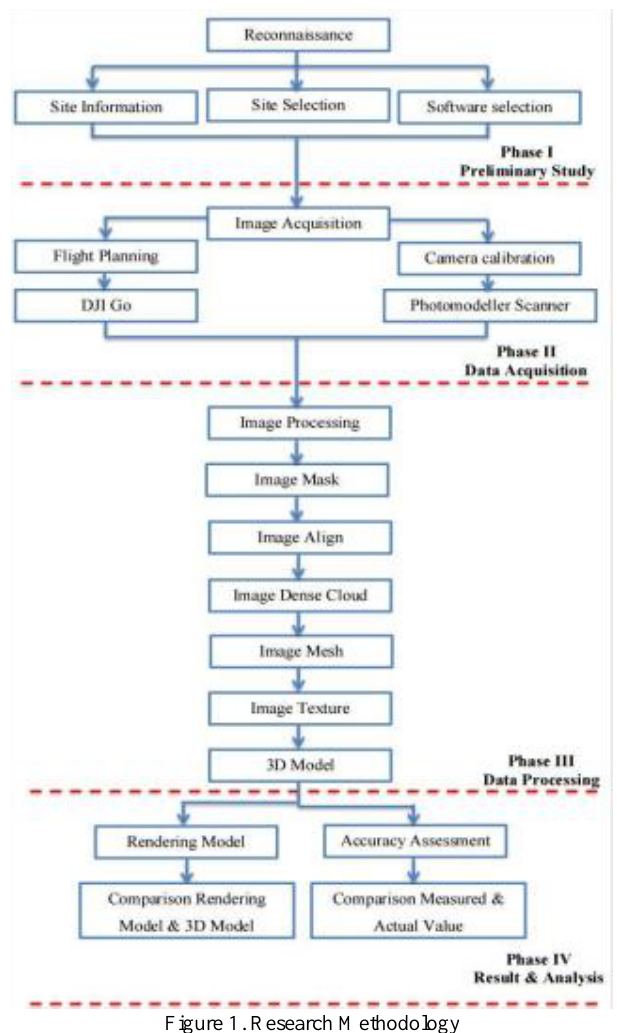
Figure 1. Research Methodology